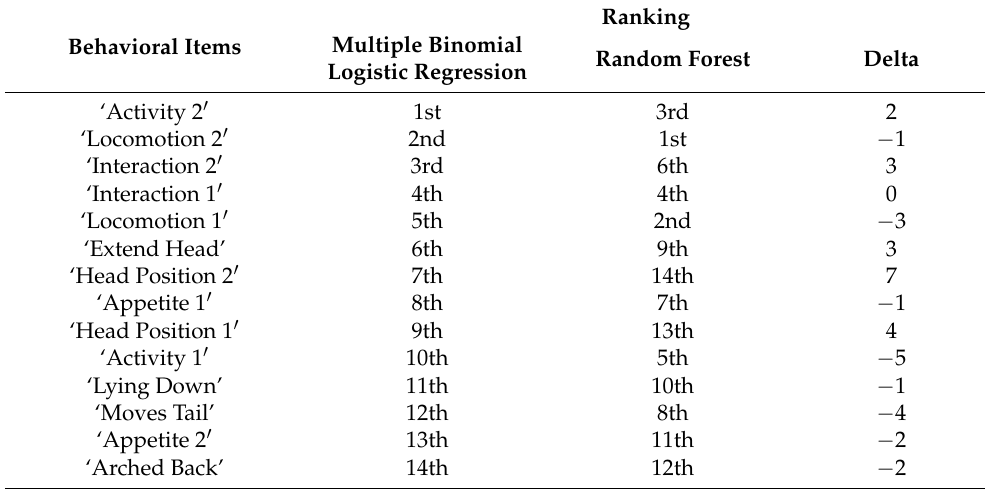
Table 4. USAPS behavior importance ranking based on two machine learning